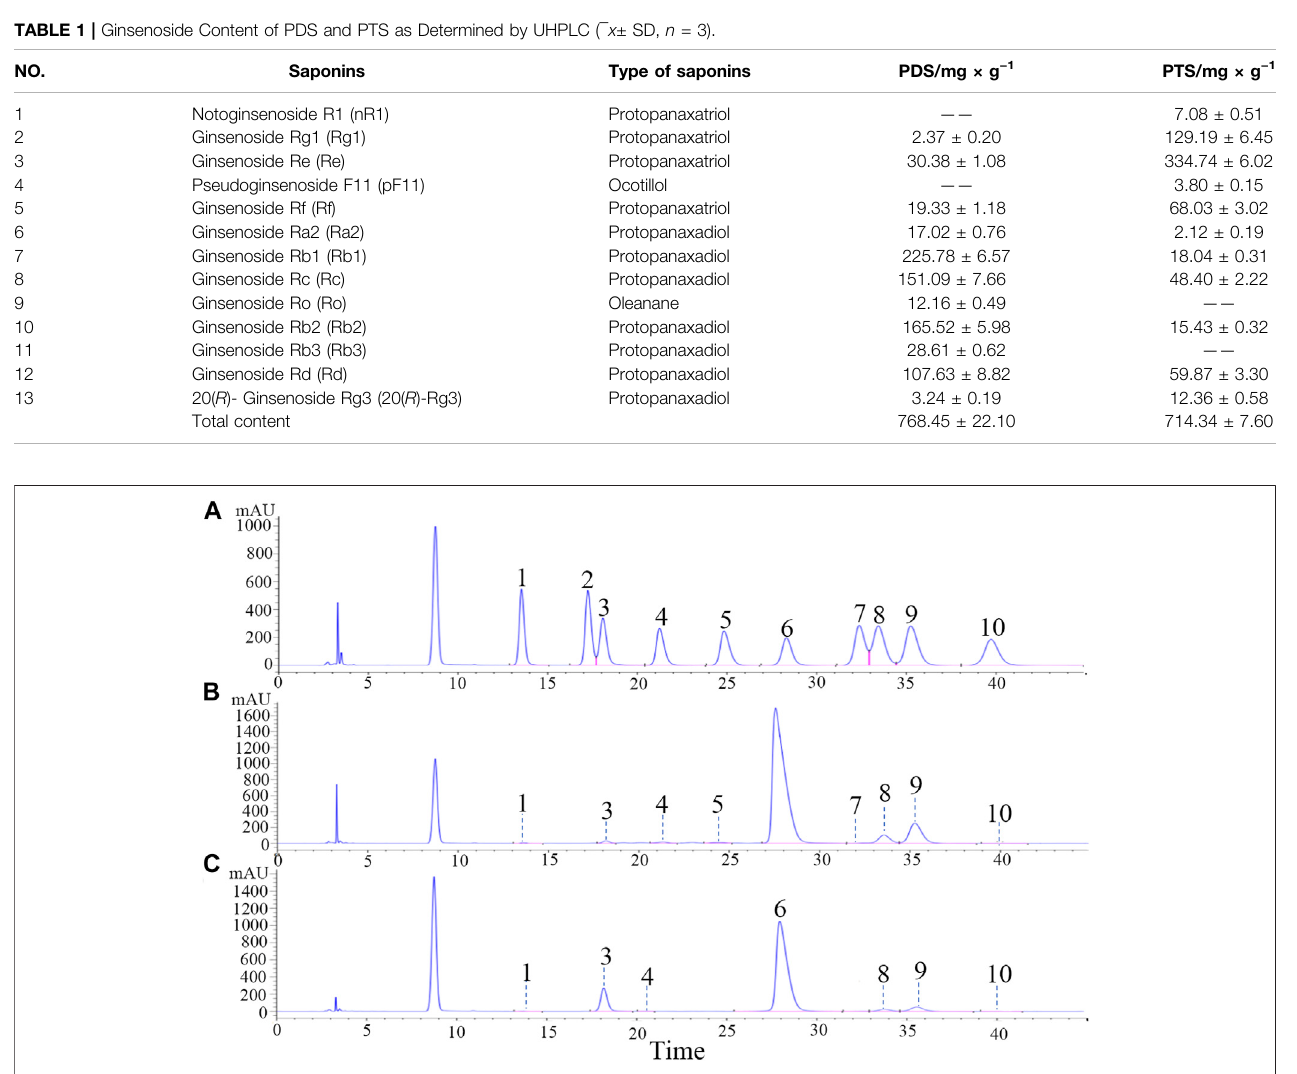
FIGURE 2 | Monosaccharide composition analysis of PDS and PTS by HPLC. (A) reference substances; (B) PDS; (C) PTS.